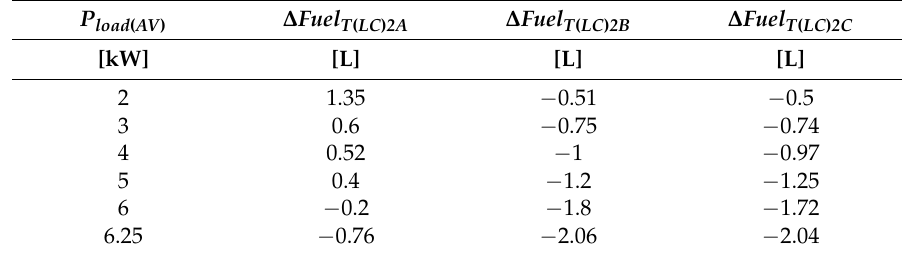
Table 10. Fuel economy under variable load demand for the RTO2 strategy using different k fuel .